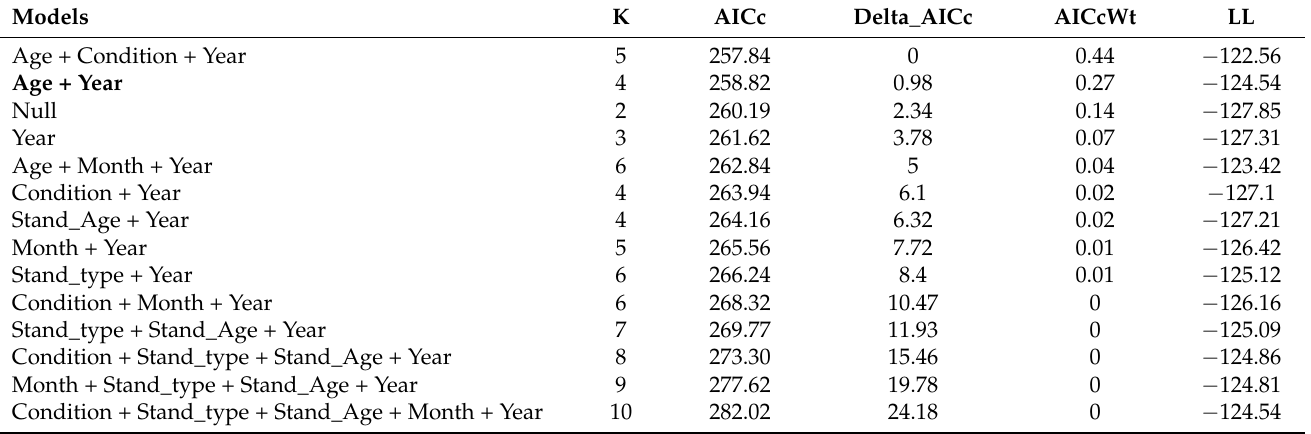
Table A3. Selection of linear models, based on Akaike criterion, explaining mushroom diversity consumed by all male white-tailed deer on Anticosti Island, Qu é bec, Canada. For each model, the number of estimated parameters (K), the second order Akaike criterion adjusted for small sample size (AICc), the delta AICc and weight (AICcWt), as well as the log-likelihood are given. Tested models include various combination of deer age (juvenile vs. adult), body condition index, forest stand type and age, as well as the month and year of harvest.